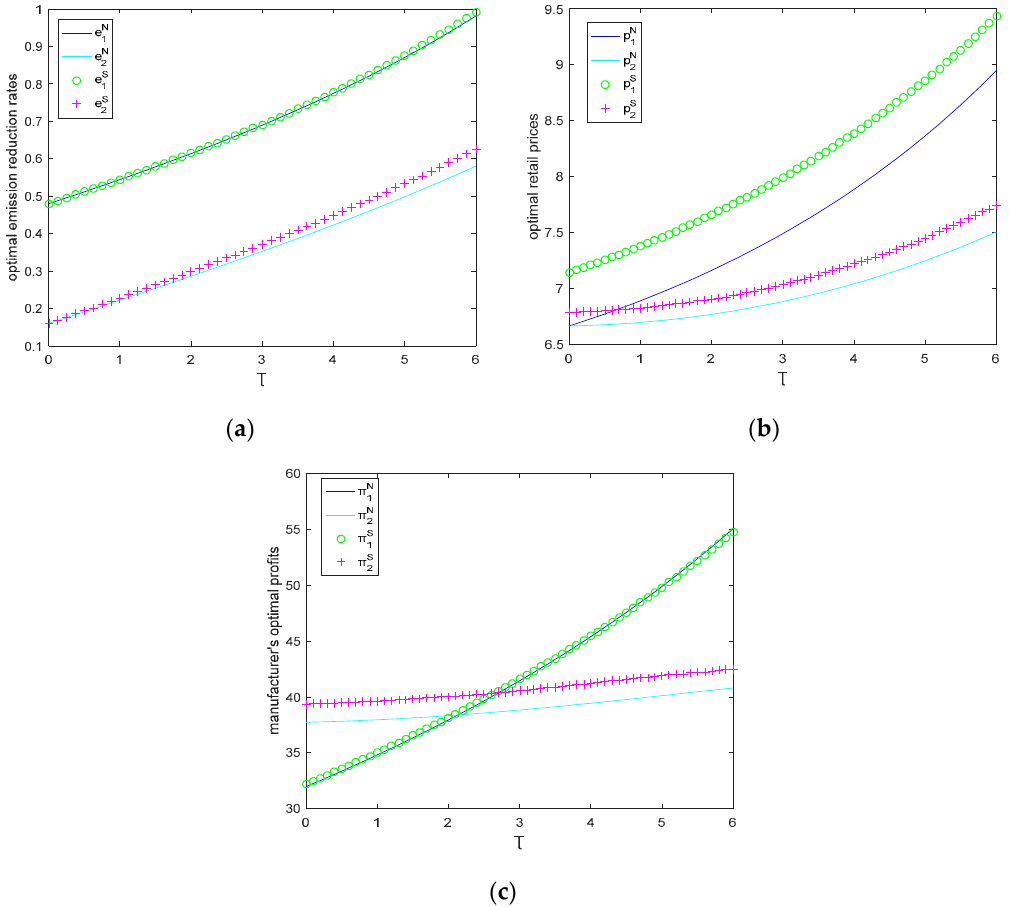
Figure 4. ( a ) Optimal emission reduction rates, ( b ) optimal retail prices, and ( c ) manufacturer’s profits as a function of τ .